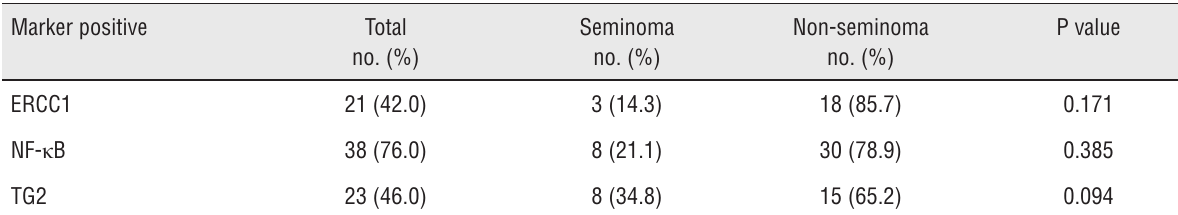
Table 2 - Immunohistochemical analysis of ERCC1, NF- κ B, and TG2 in patients with testicular cancer (n=50). Marker